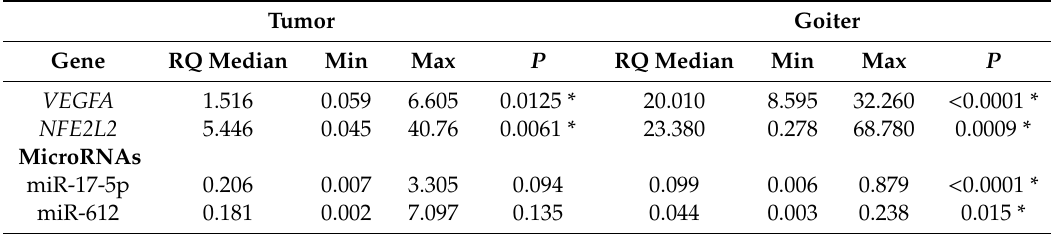
Table 2. Genes and miR expression in thyroid tumor and goiter in relation to normal thyroid tissue.